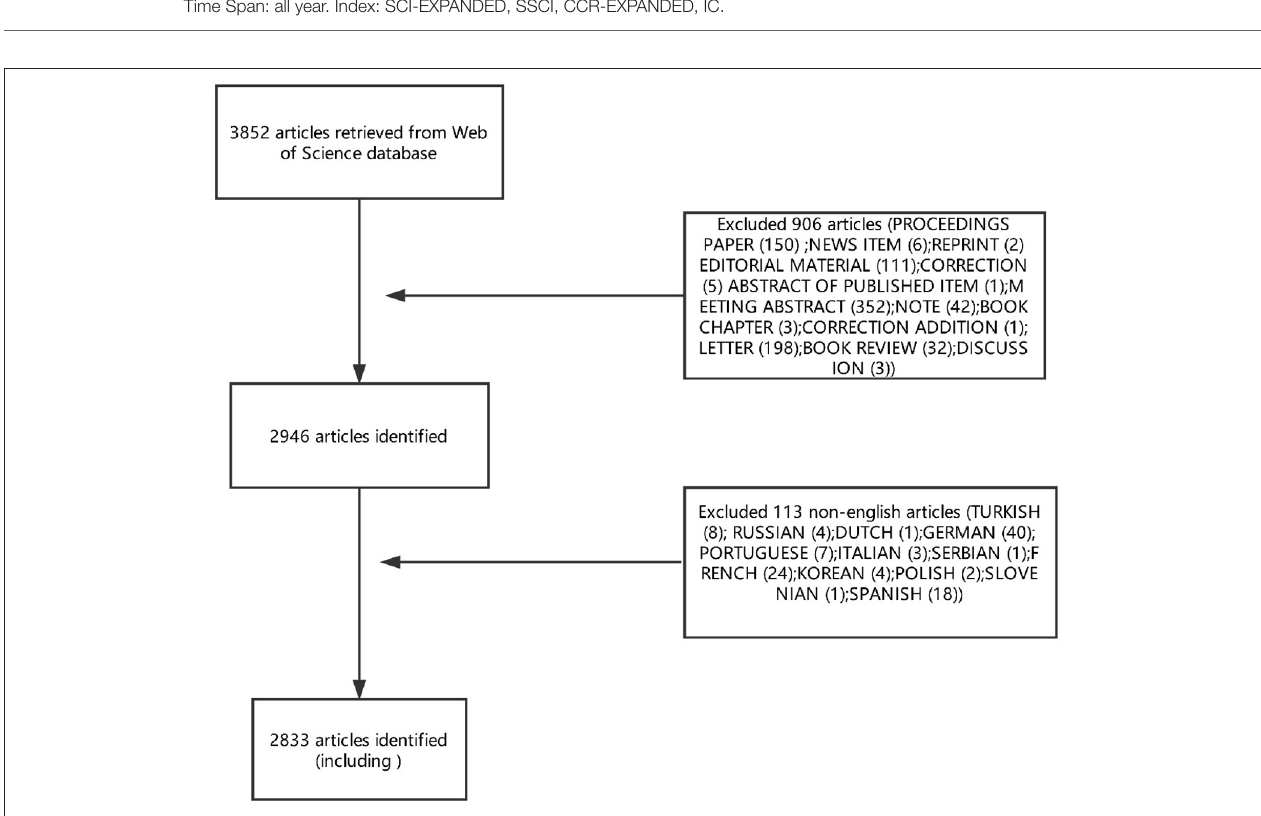
FIGURE 1 | Flow diagram of study selection of PMS/PMDD research.